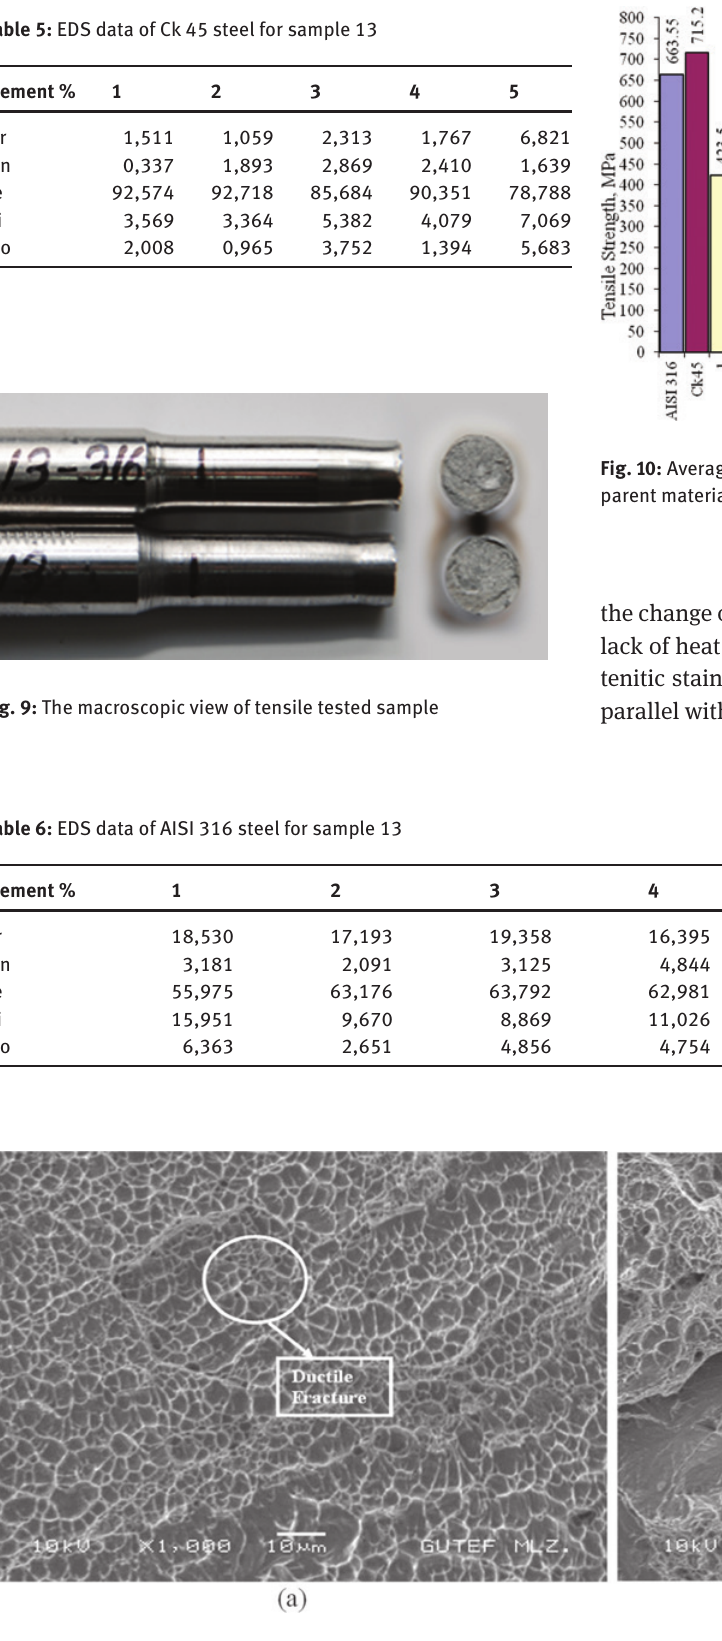
Fig. 11: FESEM images of the tensile fracture surfaces of (a) sample 13 and (b) sample